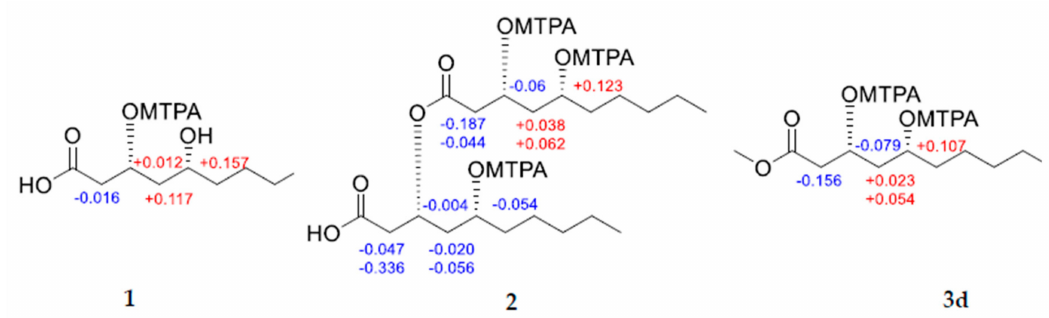
Figure 4. Observed chemical shift di ff erences ( ∆ δ S-R = δ S − δ R , in ppm, 500 MHz) for the R - and S -MTPA esters of compounds 1 , 2 , and 3d